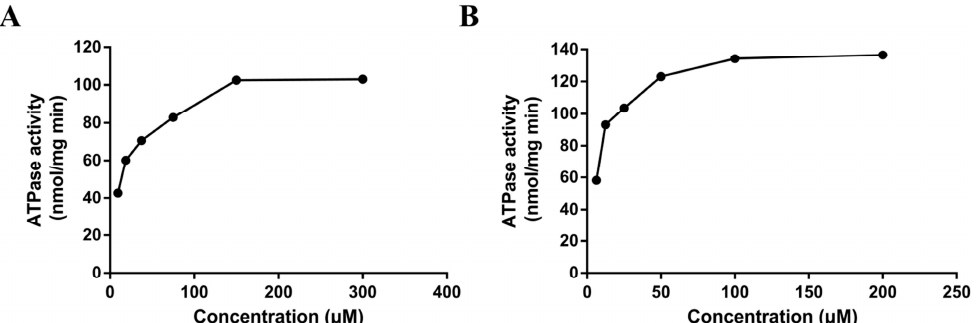
Figure 3. The P-gp ATPase activities on concentration-dependent stimulation by DL0410 ( A ) and verapamil ( B ) in human P-gp membranes. The P-gp ATPase activity was measured through Pi release. The P-gp membranes were exposed to serial concentrations of DL0410 (20–300 µM) and verapamil (2–200 µM). Data are presented as the means of triple determinations.